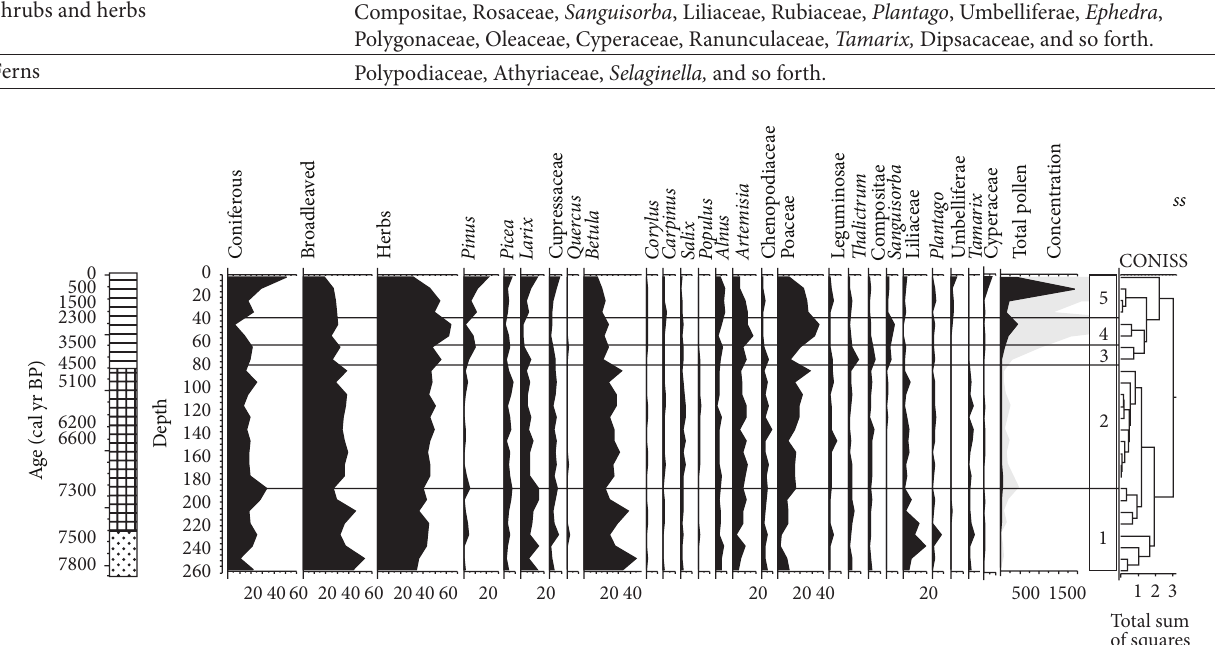
Figure 3: Pollen percentages and concentrations for the Beihong Section (the gray values to the right are magnified tenfold to emphasize changes in concentration).